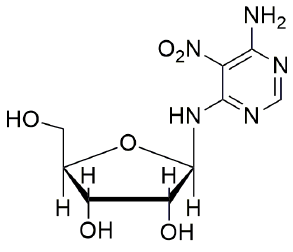
Figure 9. Structure of Clitocine.